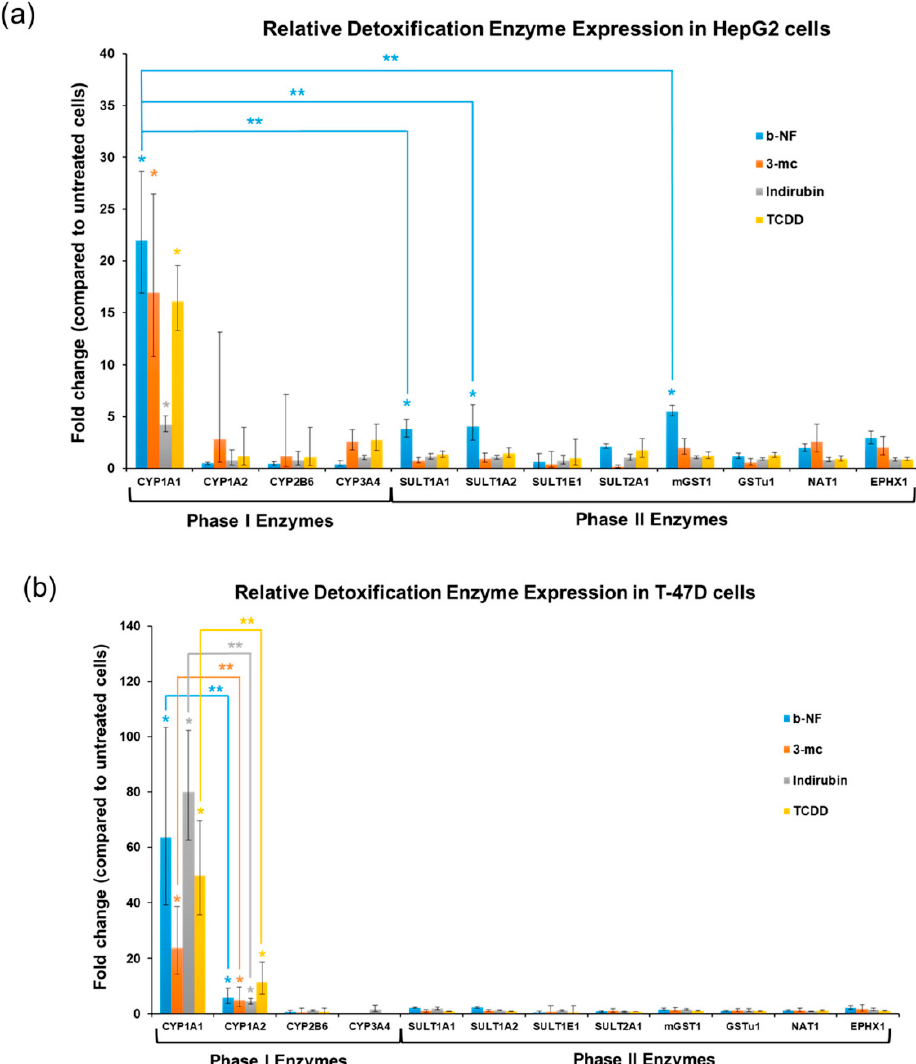
Figure 5. CYP1A1 was the most upregulated enzyme for both the ( a ) HepG2 and ( b ) T47D cell lines at the time autobioluminescent metabolic impact was reported. No significant upregulation of any Phase II detoxification enzyme was observed in the ( b ) T47D cell line, while SULT1A1, SULT1A2, and mGST1 were upregulated in the ( a ) HepG2 cell line. For each detoxification enzyme, significant induction in treated cells relative to their untreated controls ( p ≤ 0.05) is denoted by a single asterisk (*). Under a given compound treatment condition, significant differences in the level of upregulation between different detoxification enzymes is indicated by a double-asterisk (**).